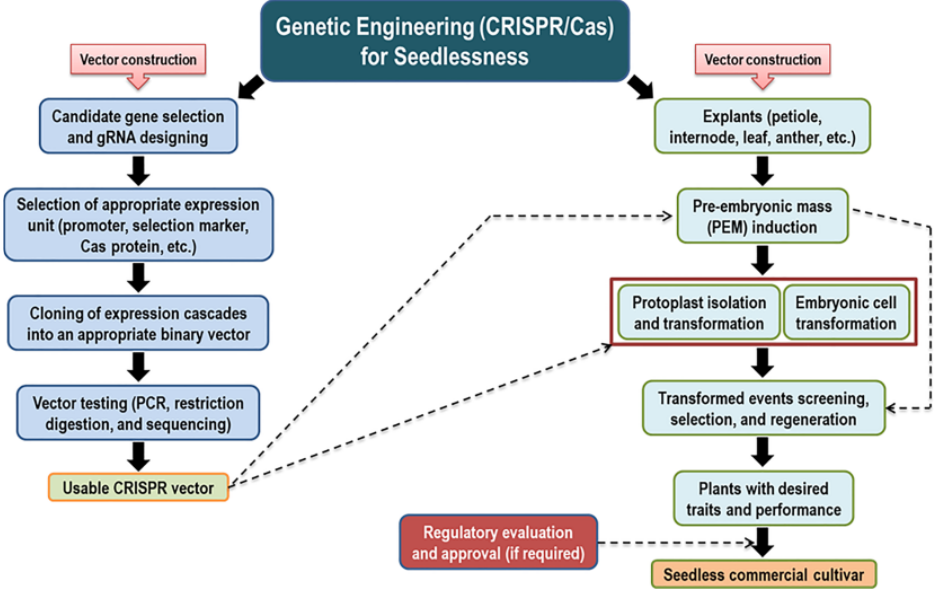
Figure 4. Visual scheme of gaining the seedlessness trait using genetic engineering (CRISPR/Cas) strategy.